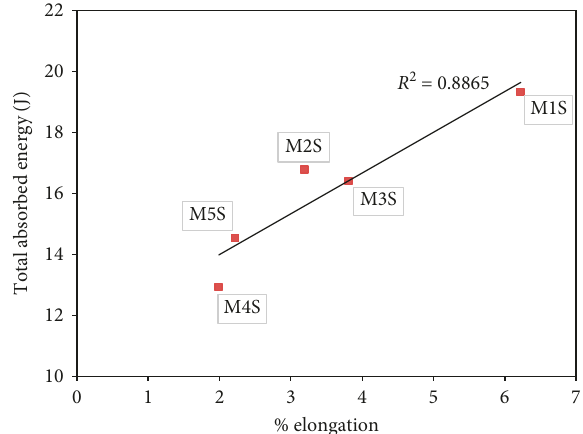
Figure 11: Correlation between impact energy and ductility values of the alloys studied in the solution-heat treated